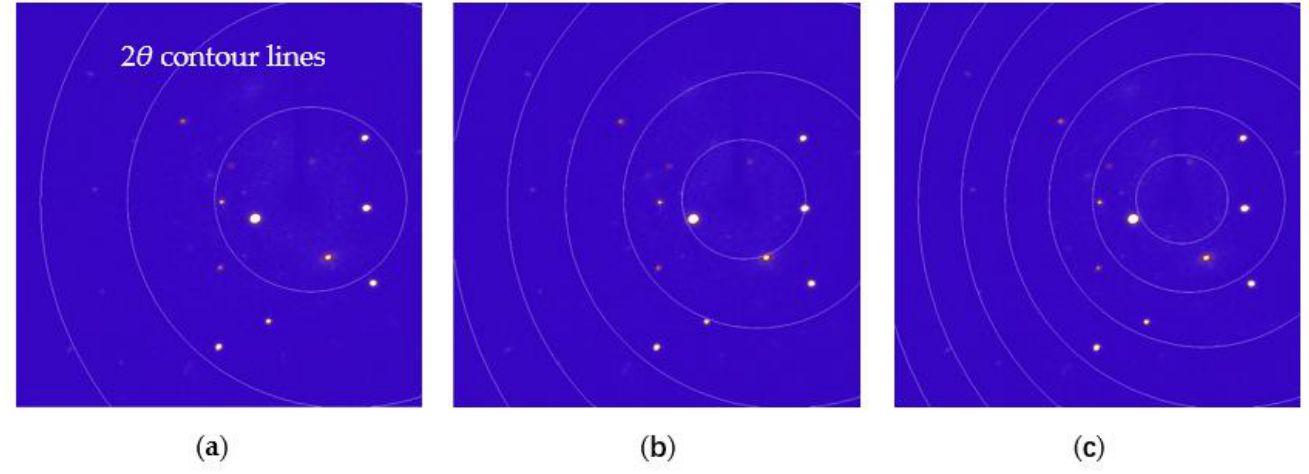
Figure 4. Three typical crystal diffraction images taken from the data collection software, which can be shown in different mode with ( a ) 3, ( b ) 5, ( c ) 7 concentric circles for convenient CIR processing. The white circle lines are the indicators of 2 θ contour lines.